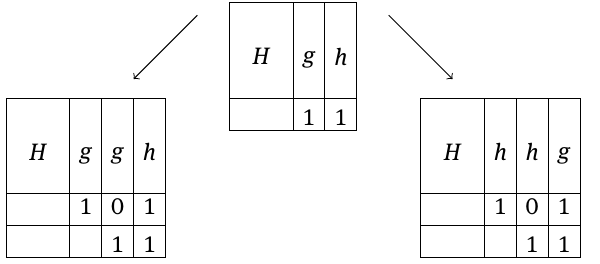
Figure 18: Splitting rule that defines the binary tree in Figure 15, in matrix form.